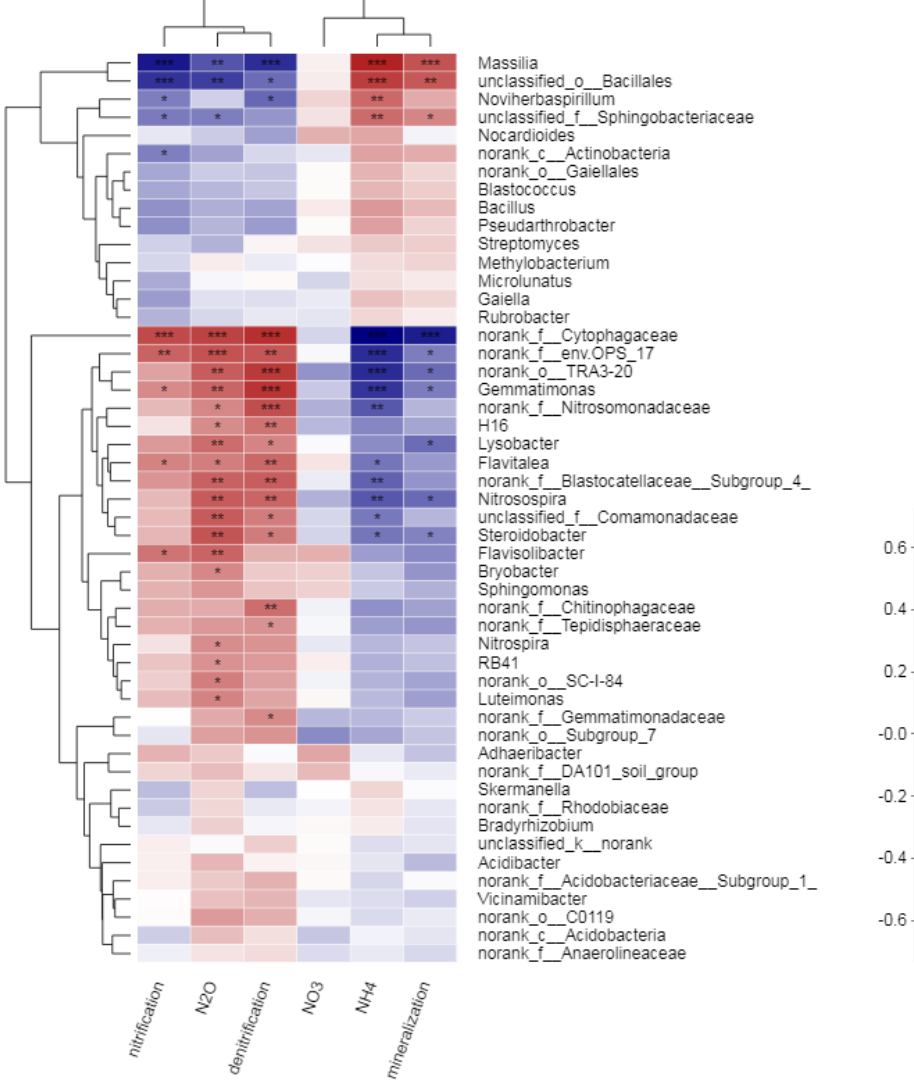
Figure 7. Spearman correlation heatmap showing the link between environmental variables and various bacterial genera. A certain color gradient is used to represent the correlation coefficient between the environmental variable and the genus; the correlation coefficient values represented by the color gradient are shown on the right bar. * p < 0.05; ** p < 0.01; *** p < 0.001. The top 50 genera in total abundance are shown. Hierarchical clustering of environmental factors: Average; hierarchical clustering of genera: Average.